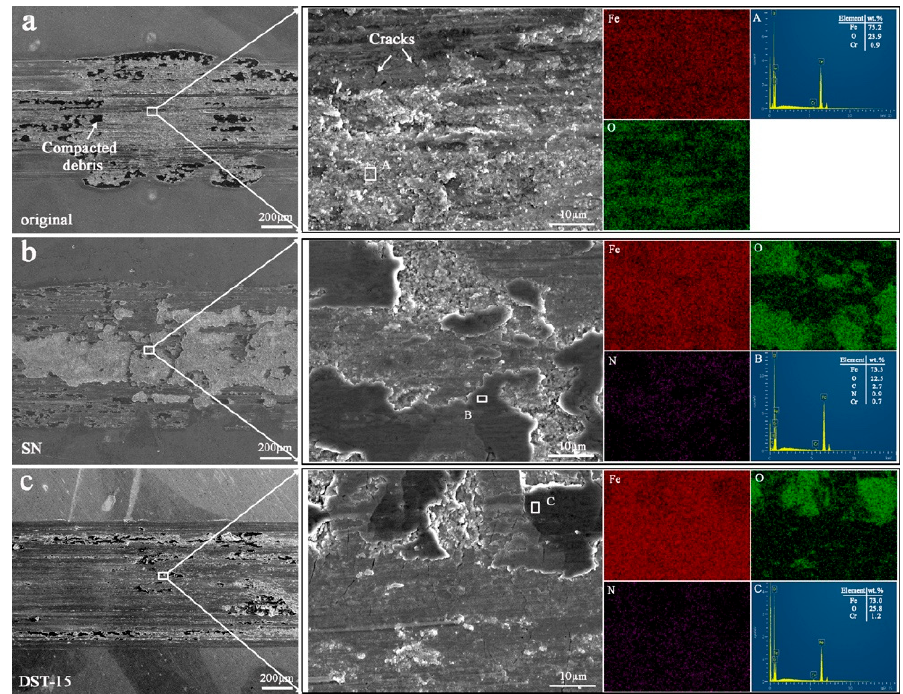
Figure 10. The low magnification morphology, high magnification morphology, and EDS element analysis of the wear scar of the original material ( a ), the SN sample ( b ), and the DST-15 sample ( c ).